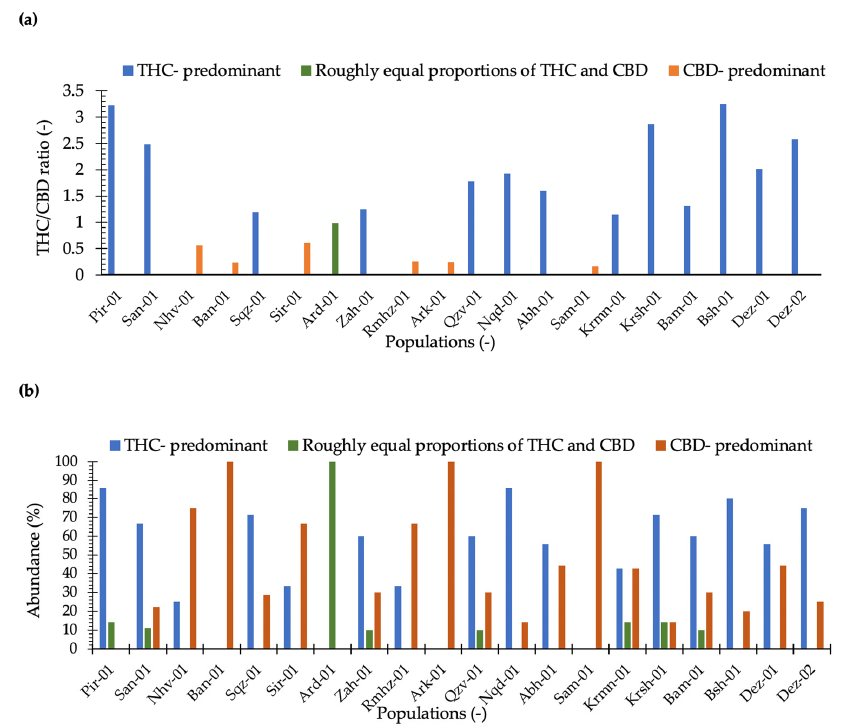
Figure 3. ( a ) THC/CBD ratio has been classified populations in three chemical phenotype groups including THC/CBD > 1 (Type I or THC-predominant), THC/CBD ≈ 1 (Type II or approximately equal proportions of THC and CBD), and THC/CBD < 1 (Type III or CBD-predominant); ( b ) the abundance (%) of Type I, Type II, and Type III plants measured for each location.